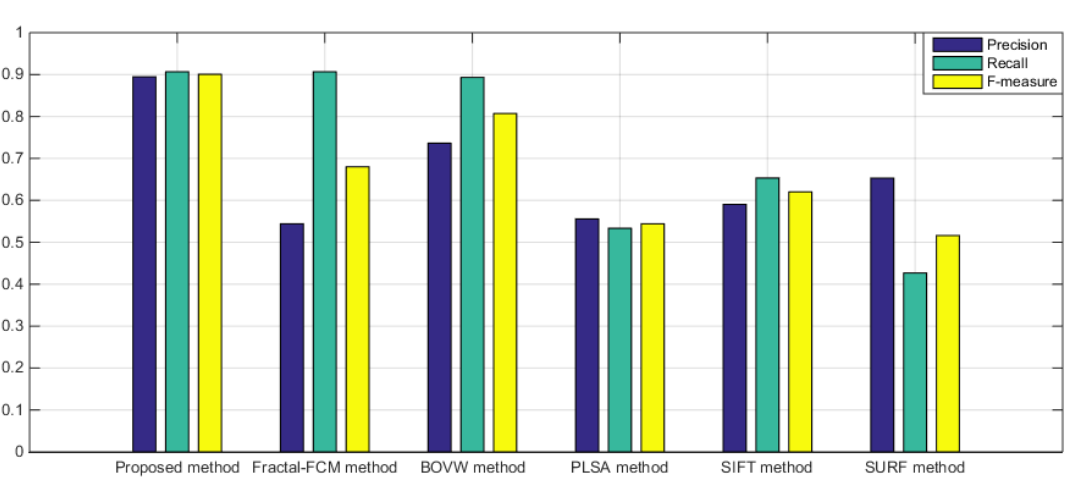
Figure 13. Precision, recall and F-measure of the performance of the proposed method and the competing models.